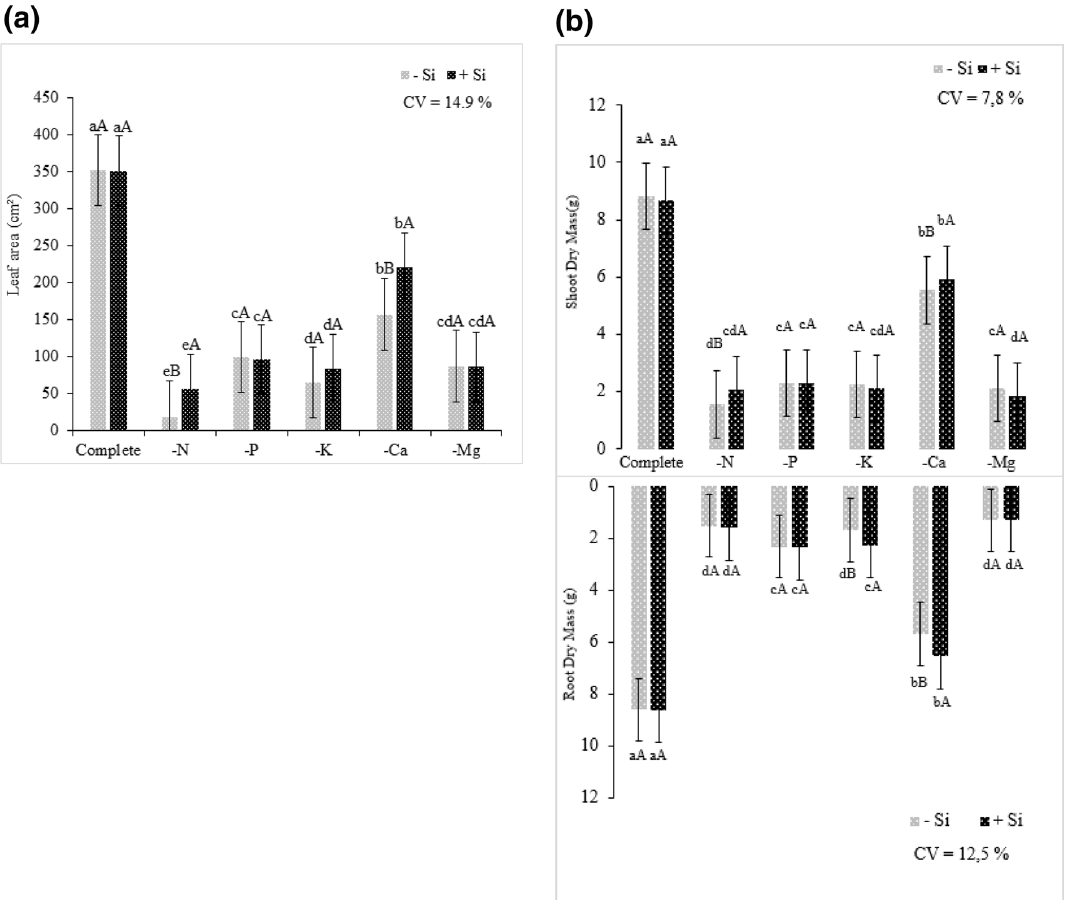
Figure 8. Biomass production of quinoa plants submitted to Hoagland solution (Hoagland and Arnon 23 ) under omission of macronutrients in the absence (− Si) and presence of silicon (+ Si), ( a ) leaf area, ( b ) shoot and root dry mass. Equal lowercase letters demonstrate a similarity between the omitted and complete treatments by Tukey’s test at 5% probability. Equal uppercase letters show a similarity between treatments (− Si and + Si) by Tukey’s test at 5% probability. Software used to create this Figure was Microsoft Excel (v1804, https:// www. micro soft.